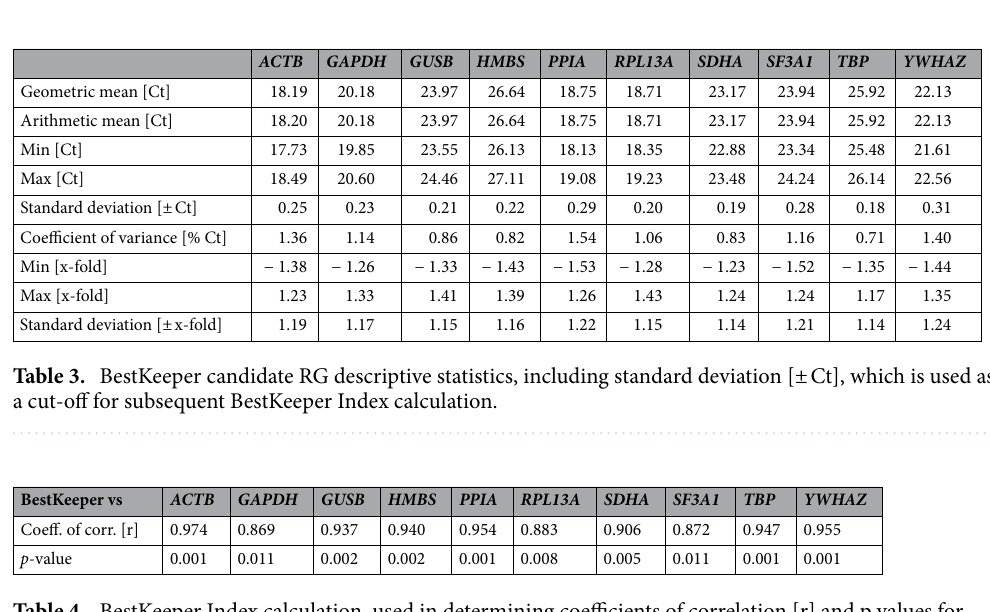
Table 4. BestKeeper Index calculation, used in determining coefficients of correlation [r] and p values for candidate RGs.